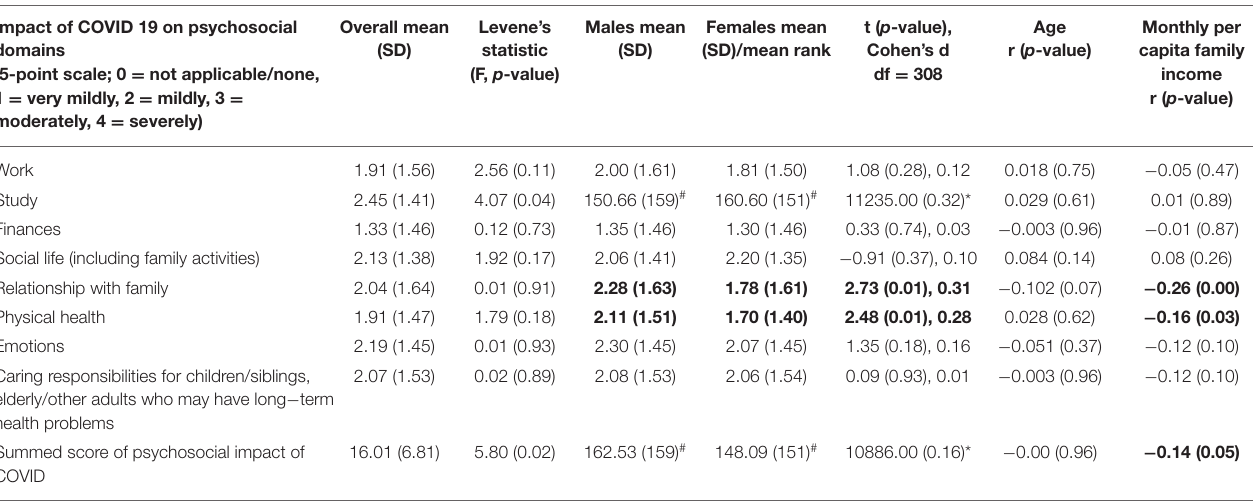
TABLE 3 | Impact of COVID-19 on psychosocial